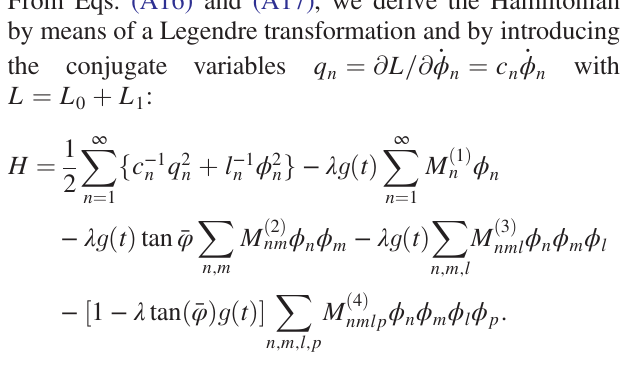
ffiffiffiffiffiffiffiffiffiffiffiffiffiffiffiffiffi 1 = 2 ω